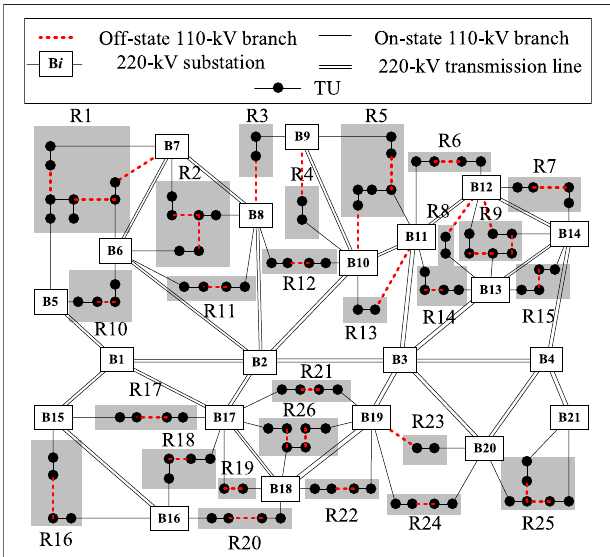
FIGURE 6 | Network con fi guration of the China 407-node urban power grid